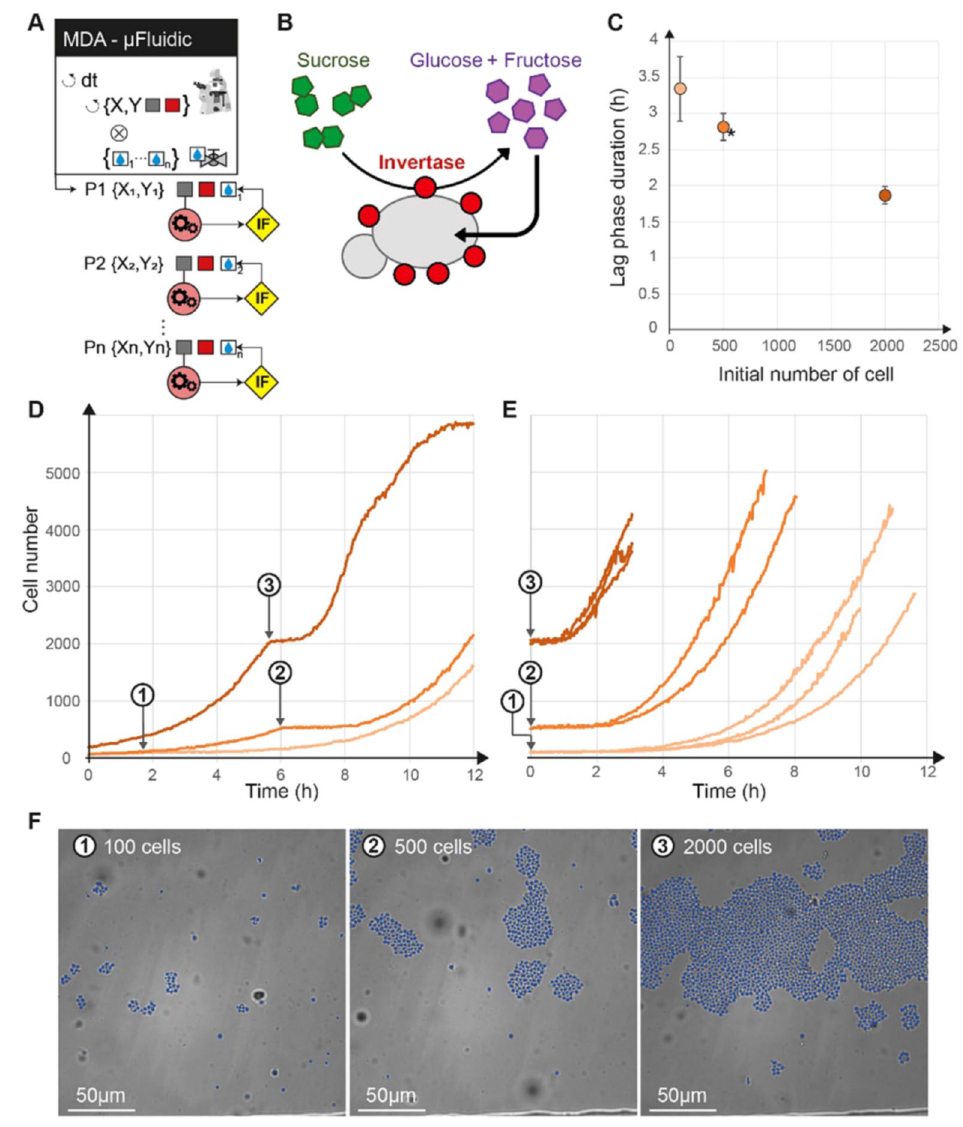
Figure 5. Conditional perturbation based on the number of cells. ( A ) Sketch of the protocol, showing that different positions have a different conditional statement ( (cid:31) IF (cid:30) ) on the number of cells to trigger the switch from glucose to sucrose independently of each other. ( B ) Sucrose conversion by yeast. The Suc2p invertase produced by cells is secreted extracellularly and can degrade extracellular sucrose into diffusible hexose. ( C ) Following a shift from glucose to sucrose, cells need some time to convert sucrose to glucose and restart division. We show here that this time depends on the initial cell density (the higher the number of cells, the shorter the lag phase). The duration of the lag phase was estimated as the time it took the population to reach 130% of its initial size after the switch from glucose to sucrose. Error bars represent ± one standard deviation over three biological replicates (two replicates for the *). ( D ) Temporal evolution of the number of cells for different initial densities: 100 (1), 500 (2) and 2000 (3) cells (grey arrows). ( E ) Population growth shifted temporally to the switch time (i.e., switch = t 0 ), demonstrating that the lag time increases as the initial cell density decreases. ( F ) Cell counting is achieved by real-time segmentation, shown here as an overlay of the brightfield image with single cell masks (in blue) at the time of the valve